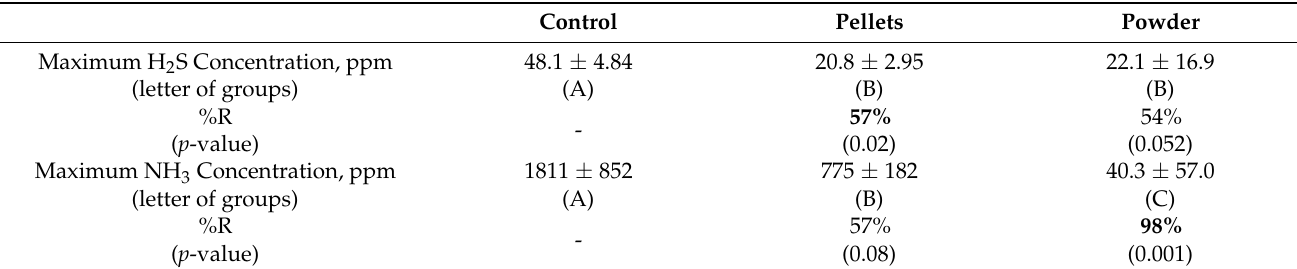
Table 1. The maximum headspace concentrations of H 2 S and NH 3 (±standard deviation) and % reductions (%R) during the 3 h agitation of swine manure averaged for n = 3 trials. Statistical significance of %R is reported as ( p -values) and bold font. The letter of the groups resulting from the ANOVA indicates significant differences.